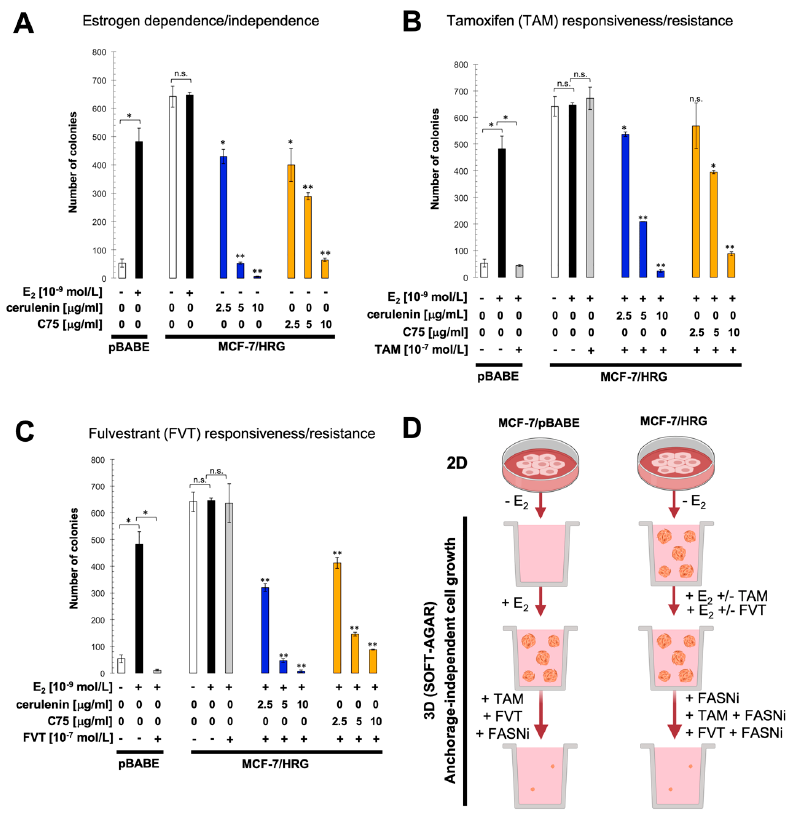
Figure 3. Pharmacological inhibition of FASN activity impedes estrogen-independent and antiestrogen-refractory cell growth of MCF-7/HRG cells. Estradiol (E 2 )-depleted cells were plated